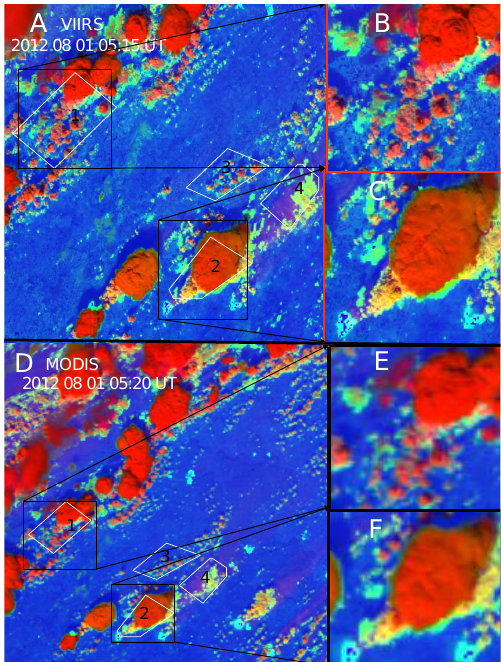
Fig. 23. Comparison between continental deep convection and pyro-Cb, as seen by VIIRS and MODIS. The data are from 1 Au- gust 2012 over eastern Siberia in an area of 306km × 289km cen- tered at 66.19 ◦ N, 107.05 ◦ E. VIIRS is shown in panels ( A–C ), and the analysis is repeated for MODIS in panels (D–F) . Areas 1 and 3 contain Cb clouds, which are magnified to full-resolution VI- IRS in panel (B) in an area of 61km × 62km centered at 65.69 ◦ N, 105.29 ◦ E and panel (C) in an area of 58km × 56km centered at 65.30 ◦ N, 107.37 ◦ E. The cloud in panel 3 is a pyro-Cb, which in- gests the smoke and heat from the fire that appears as a light-blue area just upstream of the pointed edge of the cloud. Cumulus con- vection is also compared in areas 2 and 4, with area 4 being affected by the smoke from the nearby fires. The smoky clouds are visibly brighter in this microphysical RGB because of the much smaller cloud drops. The color becomes completely red when the clouds glaciate. This is quantified in the T – r e relations shown in Fig. 24.